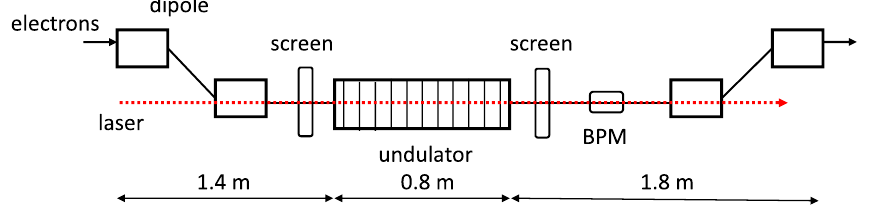
FIG. 2. Schematic of the electron beam trajectory in the laser heater chicane. The first pair of dipole magnets deflects the beam to a line parallel to the linac axis at a distance of 0.03 m from it, coinciding with the undulator axis. Then the beam is deflected again back to the linac axis by the second pair of magnets.